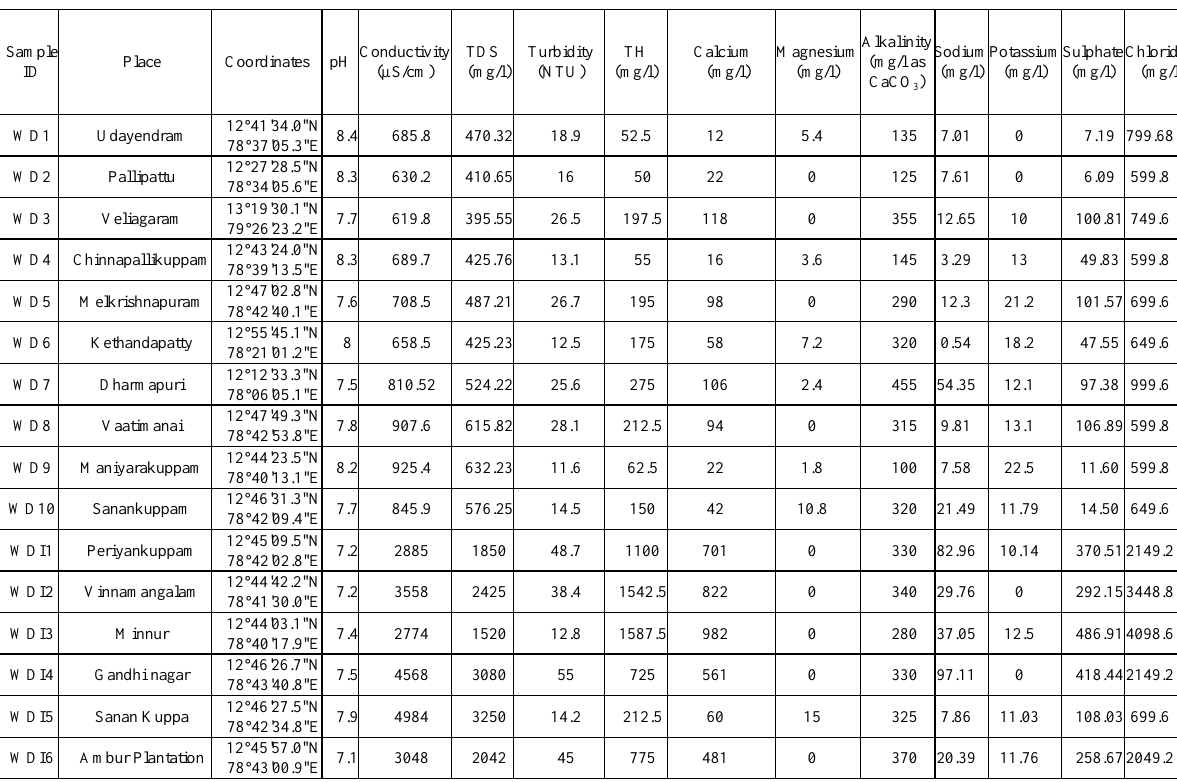
Table 1. Water quality data of Ambur city